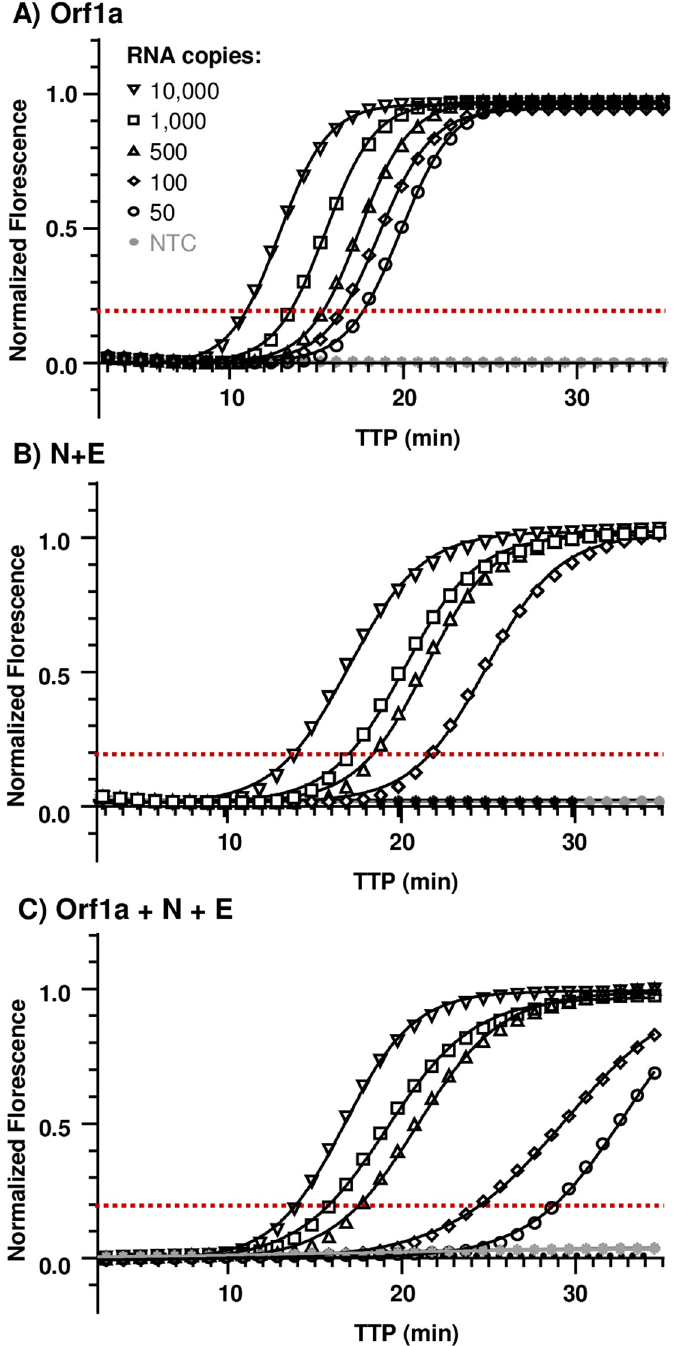
Fig 3. Limit of detection of fluorescent end-point RT-LAMP reactions targeting genomic and sub-genomic regions of SARS-CoV-2. Twist Bioscience synthetic positive control RNA (control 2 GenBank ID MN908947.3, GISAID Wuhan-Hu-1) was serially diluted to 10,000, 1,000, 500, 100, 50 and 10 copies of viral sequence per 25 μ l reaction. Water no template control (NTC) were included in each reaction. Reactions were performed at 65˚C for 40 minutes on the Qiagen Rotor-Gene Q Thermoclycler platform. Representative amplification and linear regression analysis for each primer set are shown. (A) RT-LAMP targeting the Orf1a. (B) RT-LAMP targeting N+E duplex. (C) RT-LAMP triple Orf1a+N+E target. Time to positive (TTP) is the time at which amplification exceeds the manually set, reaction consistent threshold (red dotted line) when amplification enters the rapid linear, exponential phase. Data represents the average of two experiments each performed in